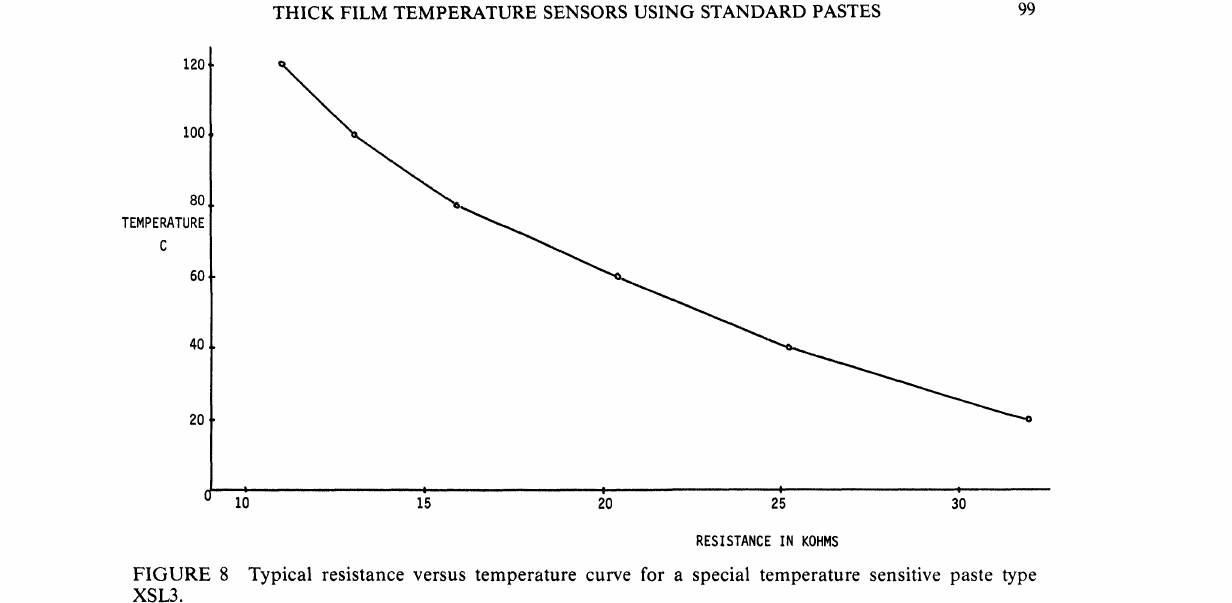
FIGURE 8 Typical resistance versus temperature curve for a special temperature sensitive paste type